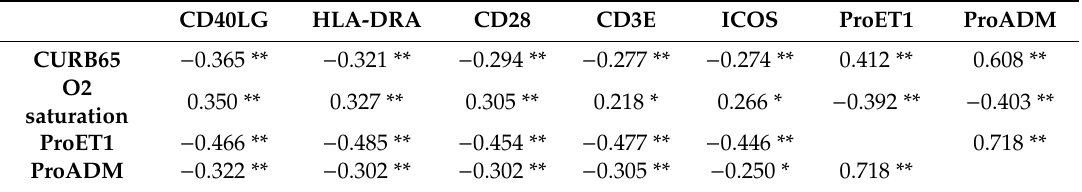
Table 2. Spearman correlations between genes and biomarkers with CURB65 and oxygen